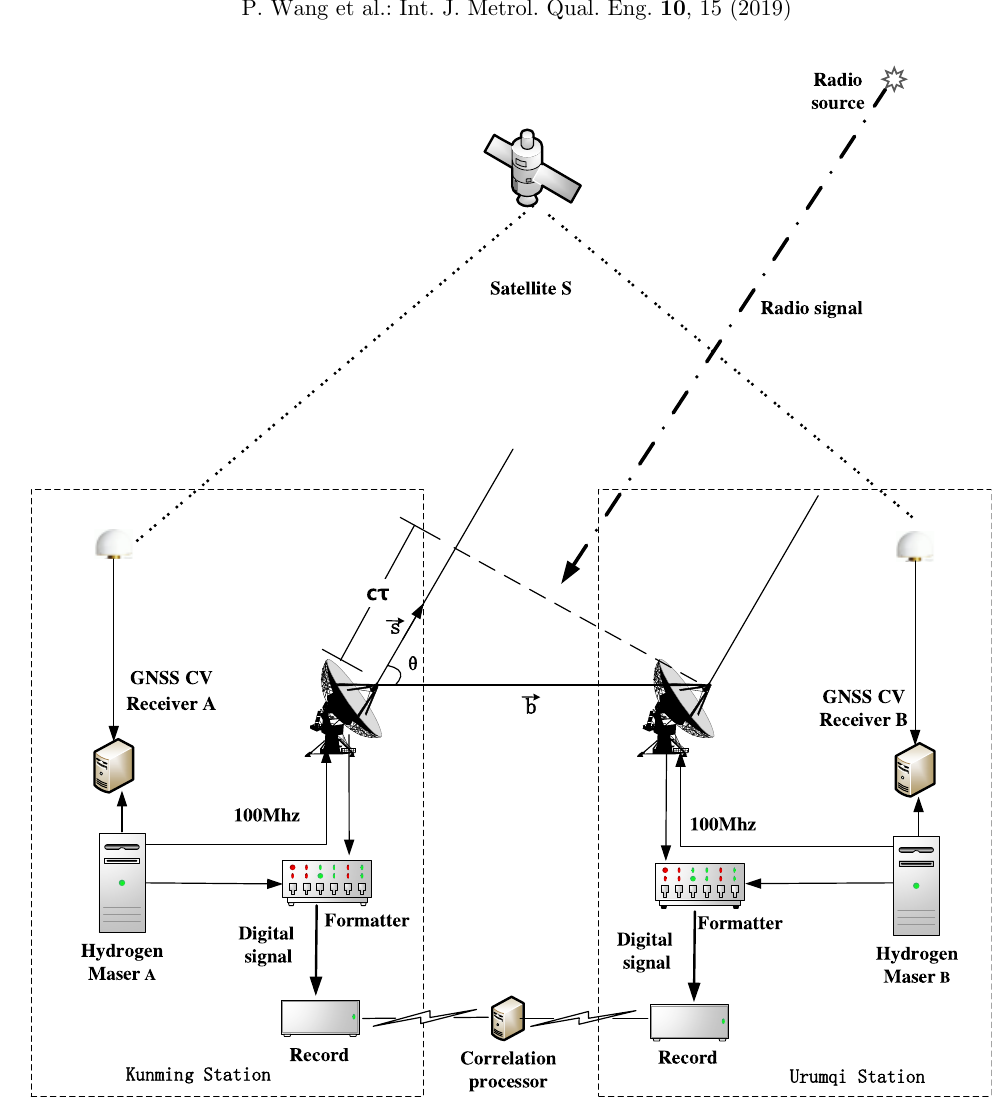
Fig. 3. Schematic diagram of a VLBI Time transfer